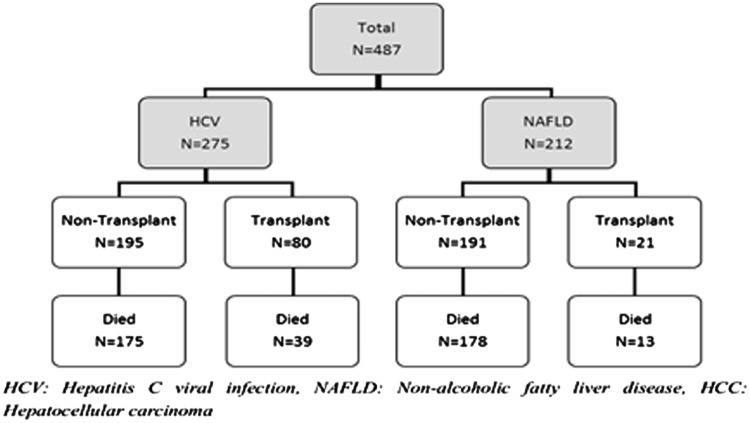
Flowchart of cohort of patients with HCC.